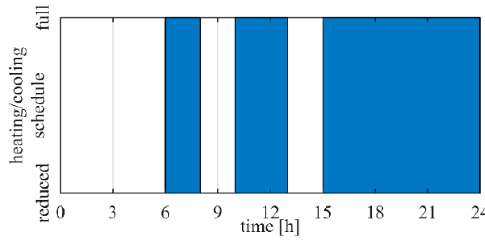
Figure 5. Heating and cooling plant daily schedule.